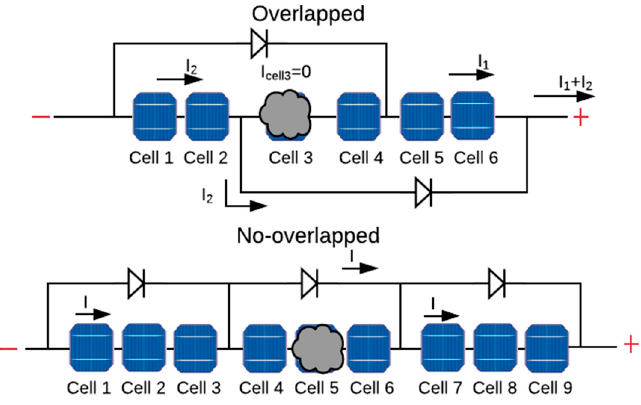
Figure 6. BP diodes’ configuration under shading condition.